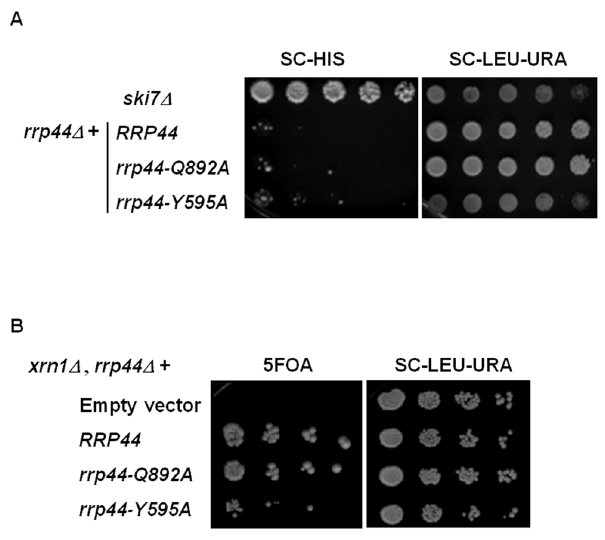
Figure 4. rrp44-Y595A and rrp44-Q892A do not have a defect in mRNA decay. A . A ski7 D strain [Vector, LEU2 ], rrp44 D [ RRP44, LEU2 ], rrp44 D [ rrp44-Q892A, LEU2 ] and rrp44 D [ rrp44-Q892A, LEU2 ] were transformed with a mutant his3 gene on a plasmid with a URA3 marker. The transformants were selected on SC-URA-LEU. Growth on SC-HIS indicates that the his3-nonstop mRNA is stabilized while failure to grow indicates normal nonstop mRNA decay. SC-LEU-URA was used as control. B . An xrn1 D rrp44 D strain containing an RRP44 , URA3 plasmid was transformed with LEU2 plasmids that encoded either no Rrp44, wild-type Rrp44, Rrp44-Q892A or Rrp44-Y595A. Growth on plates containing 5-FOA indicates that the resulting transformants are viable upon loss of the URA3 plasmid, and thus that the encoded Rrp44 is capable of degrading mRNA. SC-LEU-URA was used as control.